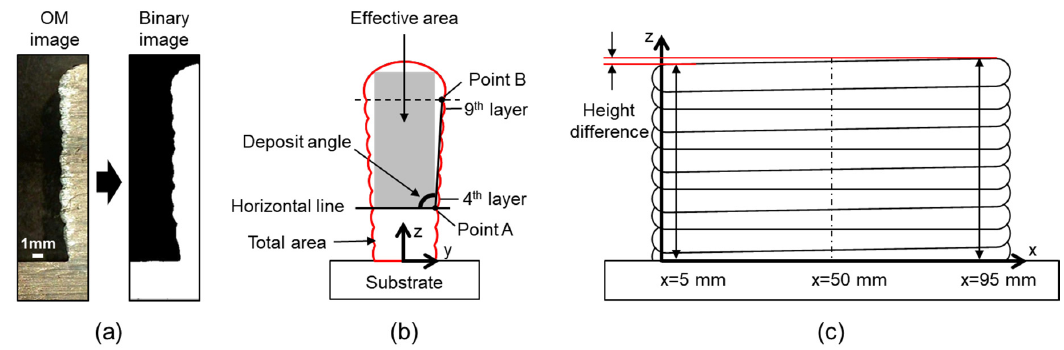
Figure 3. ( a ) Light microscope (LM) and converted binary images, ( b ) schematic showing EA and deposit angle, and ( c ) schematic showing height difference measured at both ends.